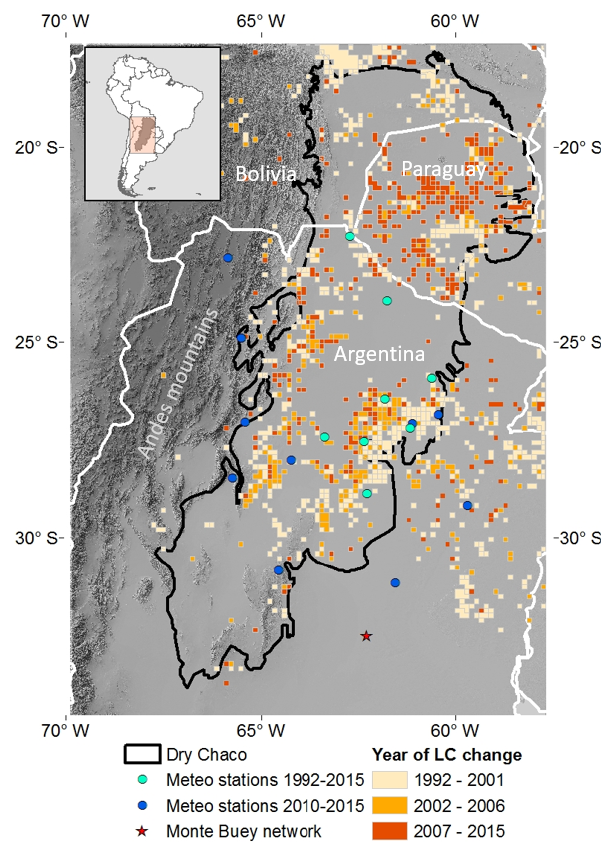
Figure 1. Geographic location of the Dry Chaco ecoregion together with the spatiotemporal pattern of land cover (LC) changes obtained from the ESA-CCI land cover product (upscaled to 0.125 ◦ resolu- tion) together with the location of the Monte Buey soil moisture site and in situ meteorological stations used for validation of soil moisture and precipitation,